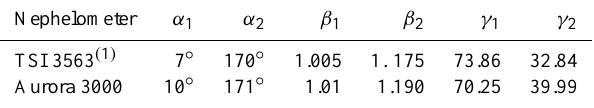
Table 2. Parameters for truncation and non-Lambertian illumina- tion correction functions. Correction functions are given for TSI model 3563 and Aurora 3000 nephelometers.